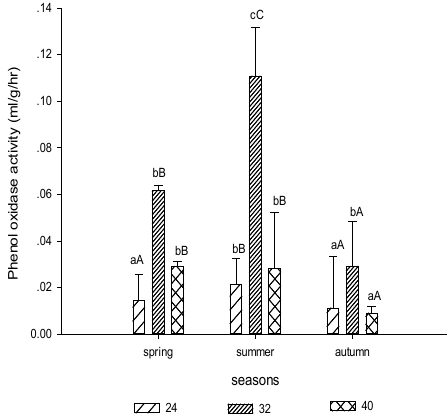
Figure 4. Change in phenol oxidase activity during the growing season in stands with different times since thinning (24, 32 and 40 years). Within each thinning age, capital letters indicate statistically significant differences among different seasons; lowercase letters indicate statistically significant differences among different times since thinning with the same season. Bars indicate the standard error of the mean.